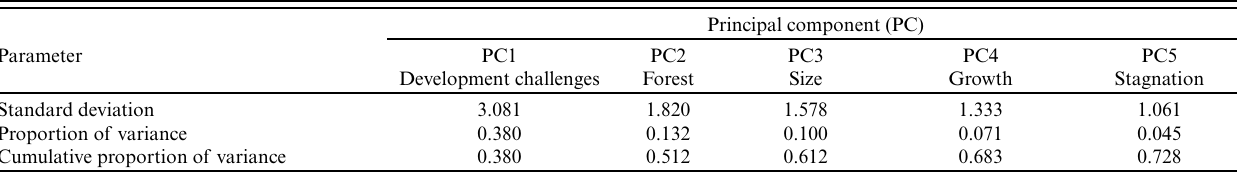
Table 2. Total variance explained by the first five principal components. Data sources: INPE (2014), IBGE (2000, 2010), and PNUD (2013).